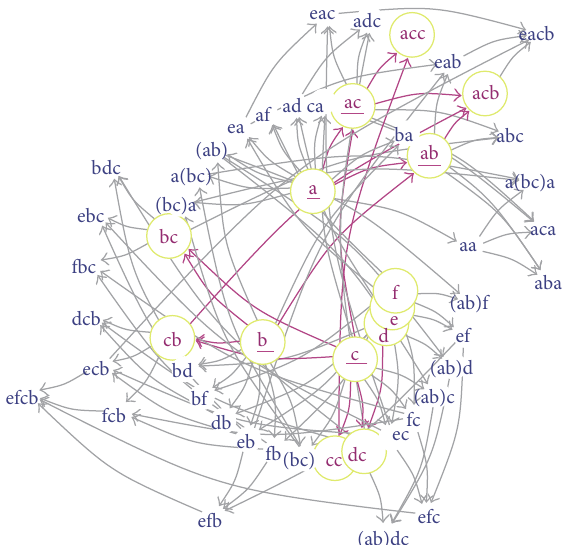
Figure 3: Network of the frequent patterns extracted at ms2 (small letters in dark blue), ms3 (large letters in dark red), and ms4 (underscored). Note : [] is omitted for the single-code chunks and is replaced by () for the multiple-code chunks for thesake of simplicity. See the first column of Table 1 for the initial